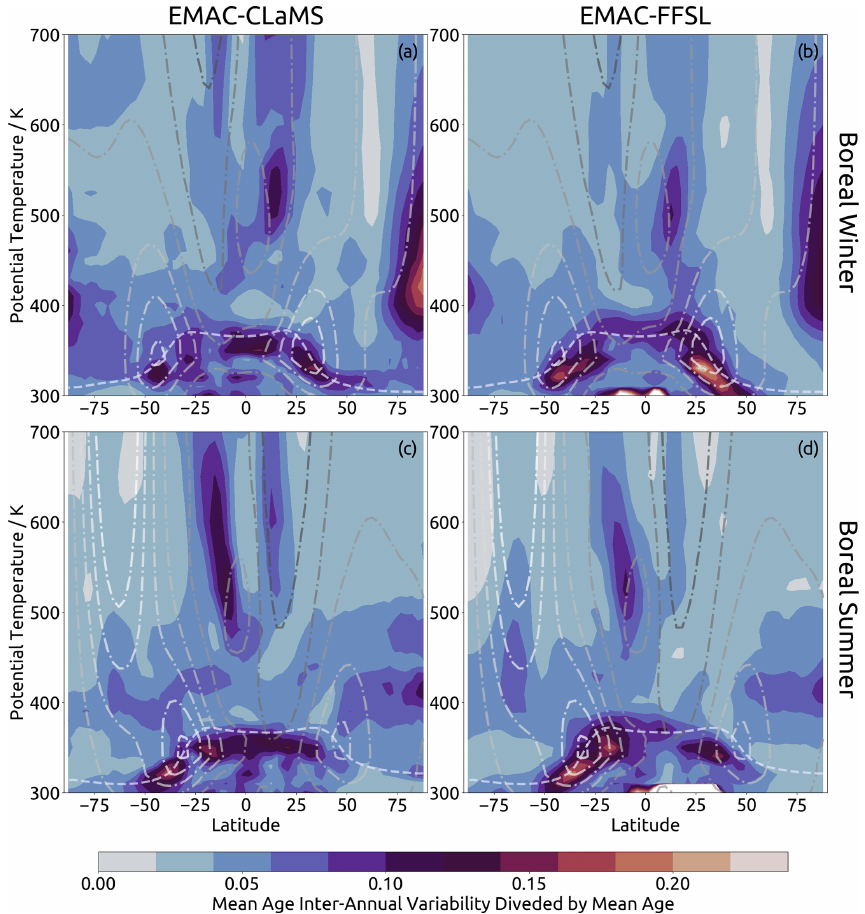
Figure 6. Same as Fig. 5, but the quantity shown is the standard deviation of spectrum mean age scaled (divided) by the spectrum mean